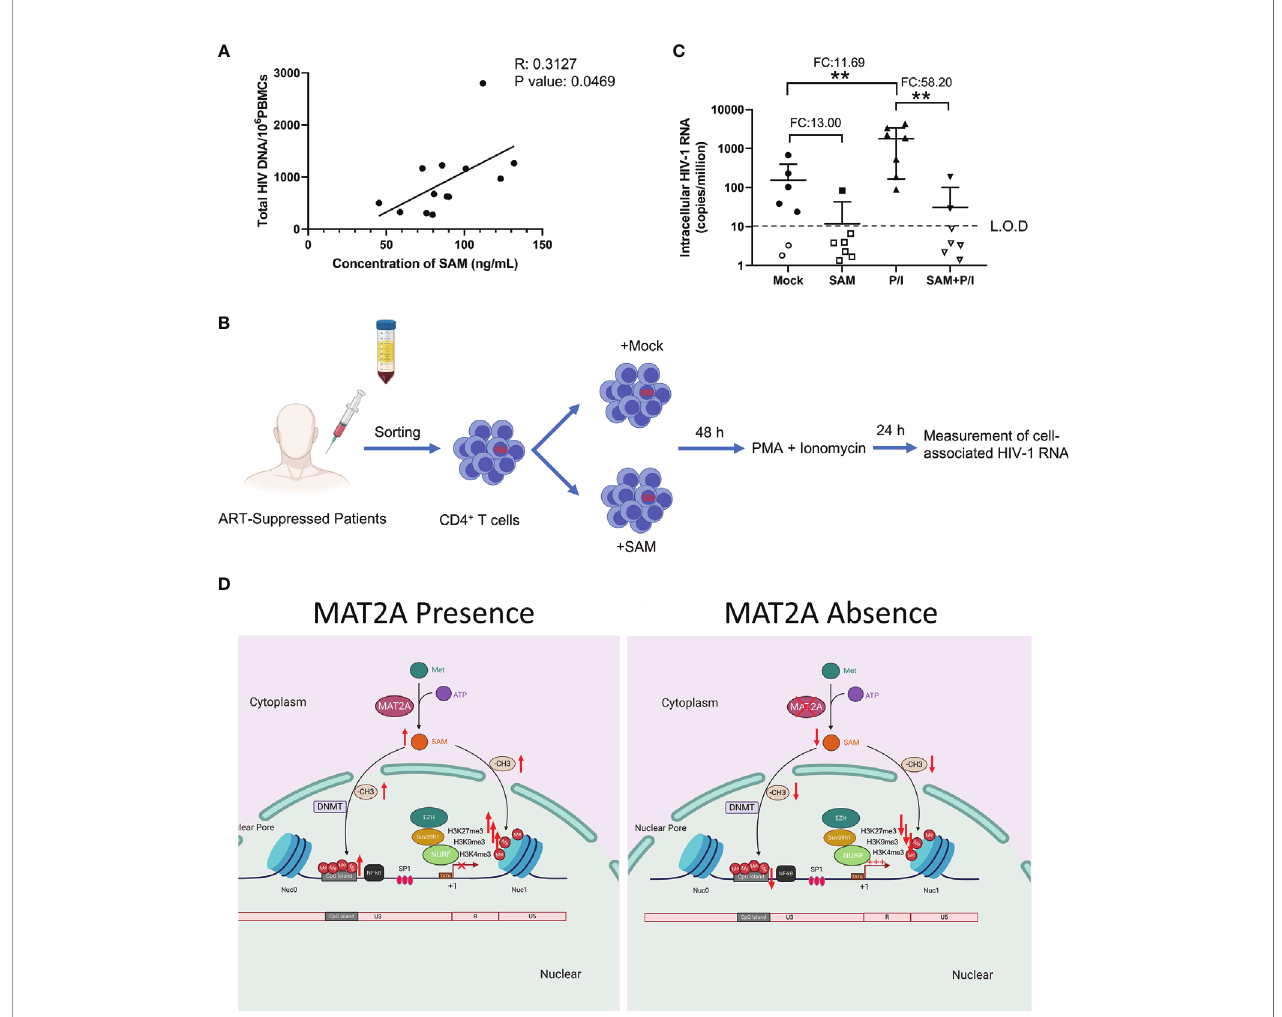
FIGURE 7 | SAM plays an important role in HIV-1 latent infection in CD4 + T cells of ART-treated HIV-1 infected individuals ex vivo . (A) Correlation between the levels of serum SAM and HIV-1 proviral DNA in PBMC from ART-treated patients. The levels of serum SAM were analyzed by LC-MS. The levels of HIV-1 proviral DNA were detected by RT-PCR. (B) Experimental design of SAM ’ s inhibitory effect on HIV-1 transcription. (C) CD4 + T cells from ART-treated HIV-1-infected patient samples were treated with DMSO or SAM and then stimulated with or without PMA and ionomycin combination. Cell-associated HIV-1 RNA was measured by VQA. FC, fold change; L.O.D, low of detection. Student ’ s t-test, **p < 0.01. (D) Schematic diagram showing the role of MAT2A in the regulation of HIV-1